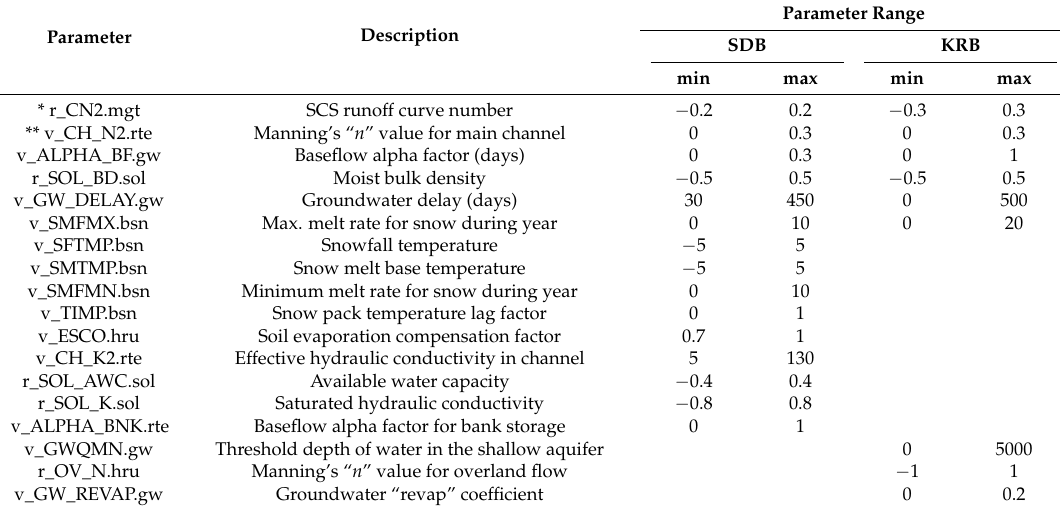
Table 3. Initial ranges and descriptions of the parameters used for calibrating the SWAT models in the Salman Dam Basin (SDB) and Karkheh River Basin (KRB).